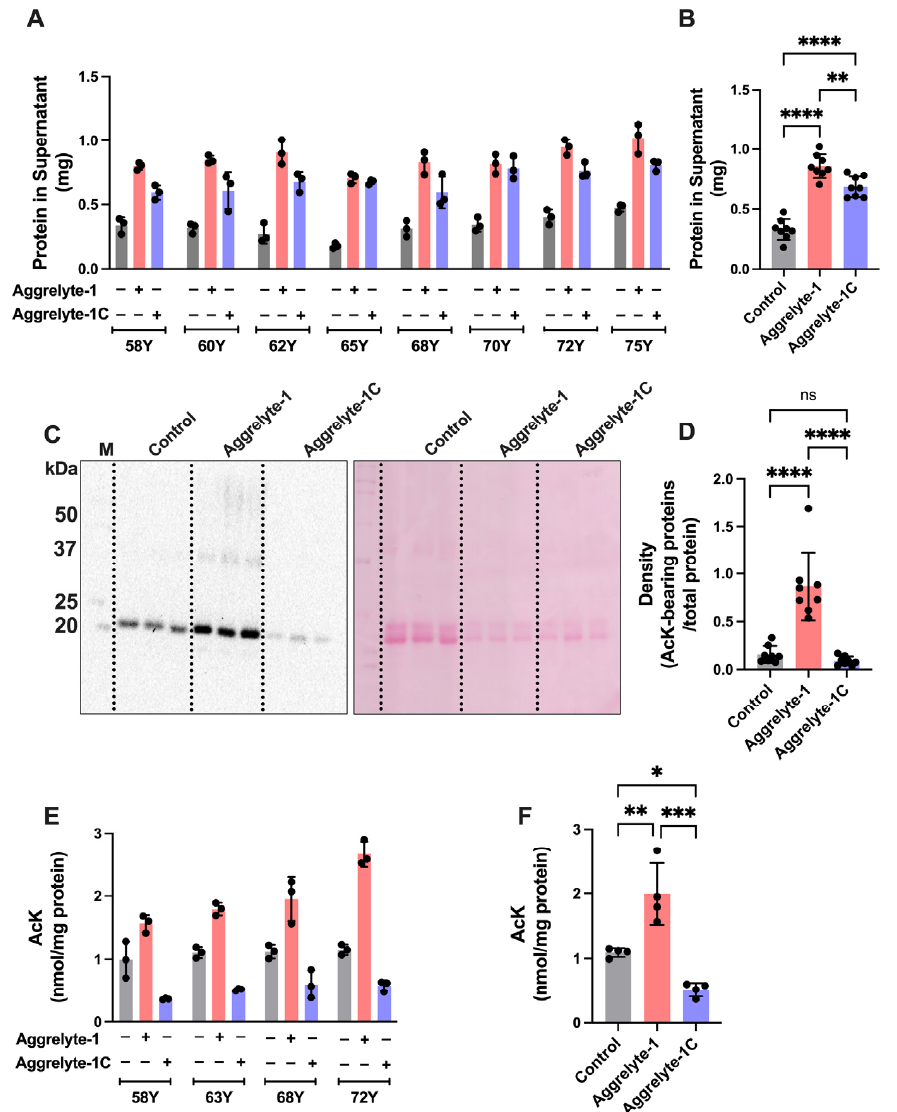
Figure 3. Aggrelytes increased the solubility of human lens WI and increased AcK levels in solubilized proteins. Two milligrams of WI from the human lens (58–75 years) was suspended in 0.4 mL of 50 mM phosphate buffer, pH 7.4, and the solutions were incubated with 2000 µ M aggrelyte-1 or aggrelyte-1C for 24 h at 37 ◦ C. Each sample was separately processed three times and analyzed (mean ± S.D.) ( A ). The combined effects of the aggrelytes on the solubilization of WI (from 8 lenses) are shown in panel ( B ). Representative Western blotting image shows the increase in the AcK-bearing protein content after aggrelyte-1 treatment ( C ). The samples were separately processed three times and analyzed. Five micrograms of protein from each sample were used for Western blotting. The ponceau S-stained membrane showed protein loading. WS from 8 lenses (58 to 75 years) was separately processed three times and analyzed by Western blotting for AcK-bearing proteins. The combined values obtained from the protein of 8 lenses (mean ± S.D.) are shown ( D ). WS (from 58-, 63-, 68- and 72-year-old human lenses) samples were digested with a series of enzymes and analyzed by LC–MS/MS for AcK content. Each sample was processed in triplicate and analyzed, and the bar graphs represent the mean ± S.D. ( E ). A combined plot of the mean values of the three analyses of each sample is shown in ( F ). * p < 0.05, ** p < 0.01, *** p < 0.001, **** p < 0.0001, ns = not